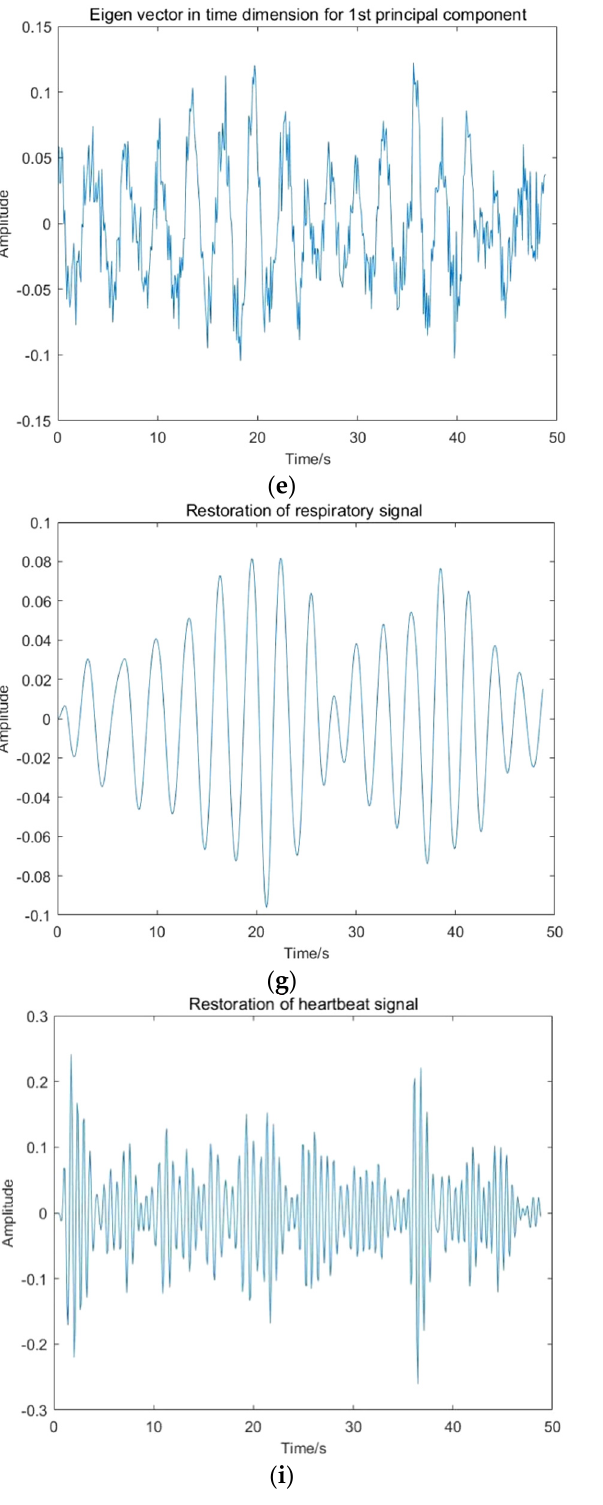
Figure 29. Results of essential steps for experiment group 6: ( a ) Radar raw data; ( b ) Radar data after preprocessing; ( c ) The relative principal component; ( d ) Spatial eigenvector; ( e ) Temporal eigenvector; ( f ) Energy entropy; ( g ) Restoration of respiratory signal; ( h ) Respiratory signal spectrum; ( i ) Restoration of heartbeat signal; ( j ) Heartbeat signal spectrum.